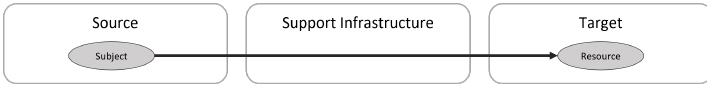
Figure 1. High-level data-flow required for remote access to a